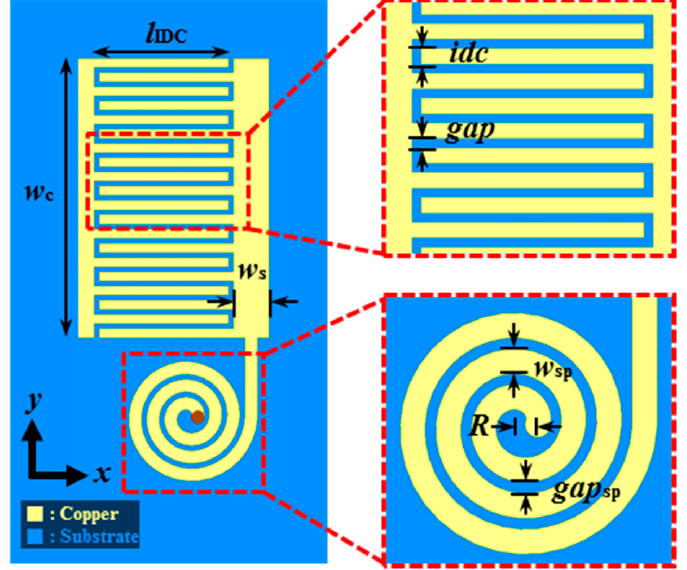
Figure 9. CRLH transmission line unit cell.